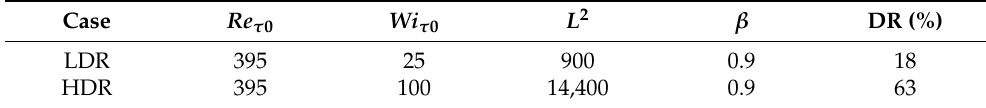
Table 1. Parameters of the two channel flow cases. LDR and HDR means a low and high DR rate, respectively. Re τ 0 denotes the Reynold number. Wi τ 0 represents the Weissenberg number. L represents the maximum extensibility of the polymer. β represents the solvent viscosity ratio.